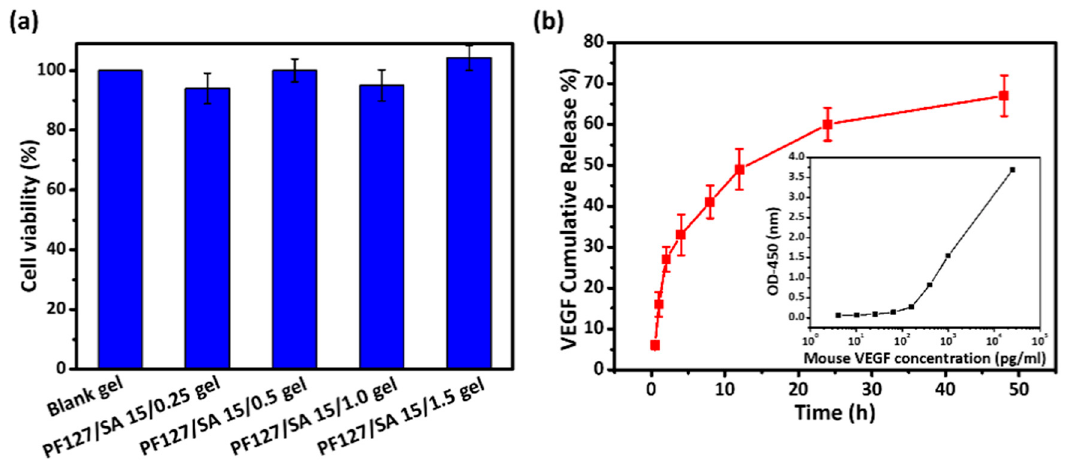
Figure 6. ( a ) In vitro cytotoxicity of PF127/SA IPN hydrogels. MTT assay was used to determine the concentration-dependent cell viability of HaCaT cells after 24 h of treatment with extracts after gelation (hydrogel state, with calcium) while the blank gel was only treated with DMEM (as a control). ( b ) In vitro VEGF release profile from PF127/SA IPN hydrogels over 48 h at 37 °C. The inset in (b) of a standard curve was measured following the manufacturer’s recommendation. (MTT,